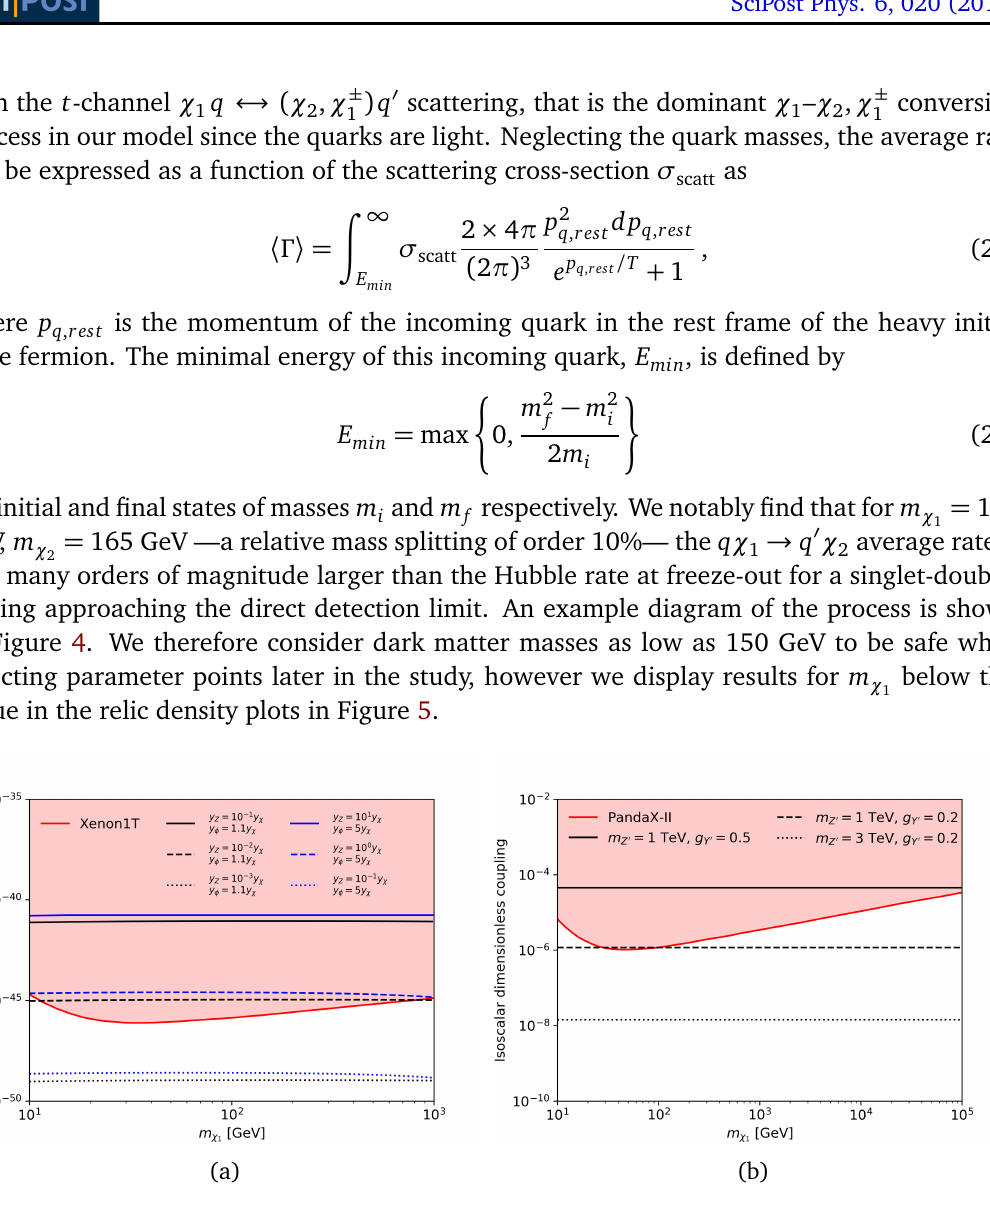
L , R where we have used the shorthand L , R arising from con- Y (cid:48)